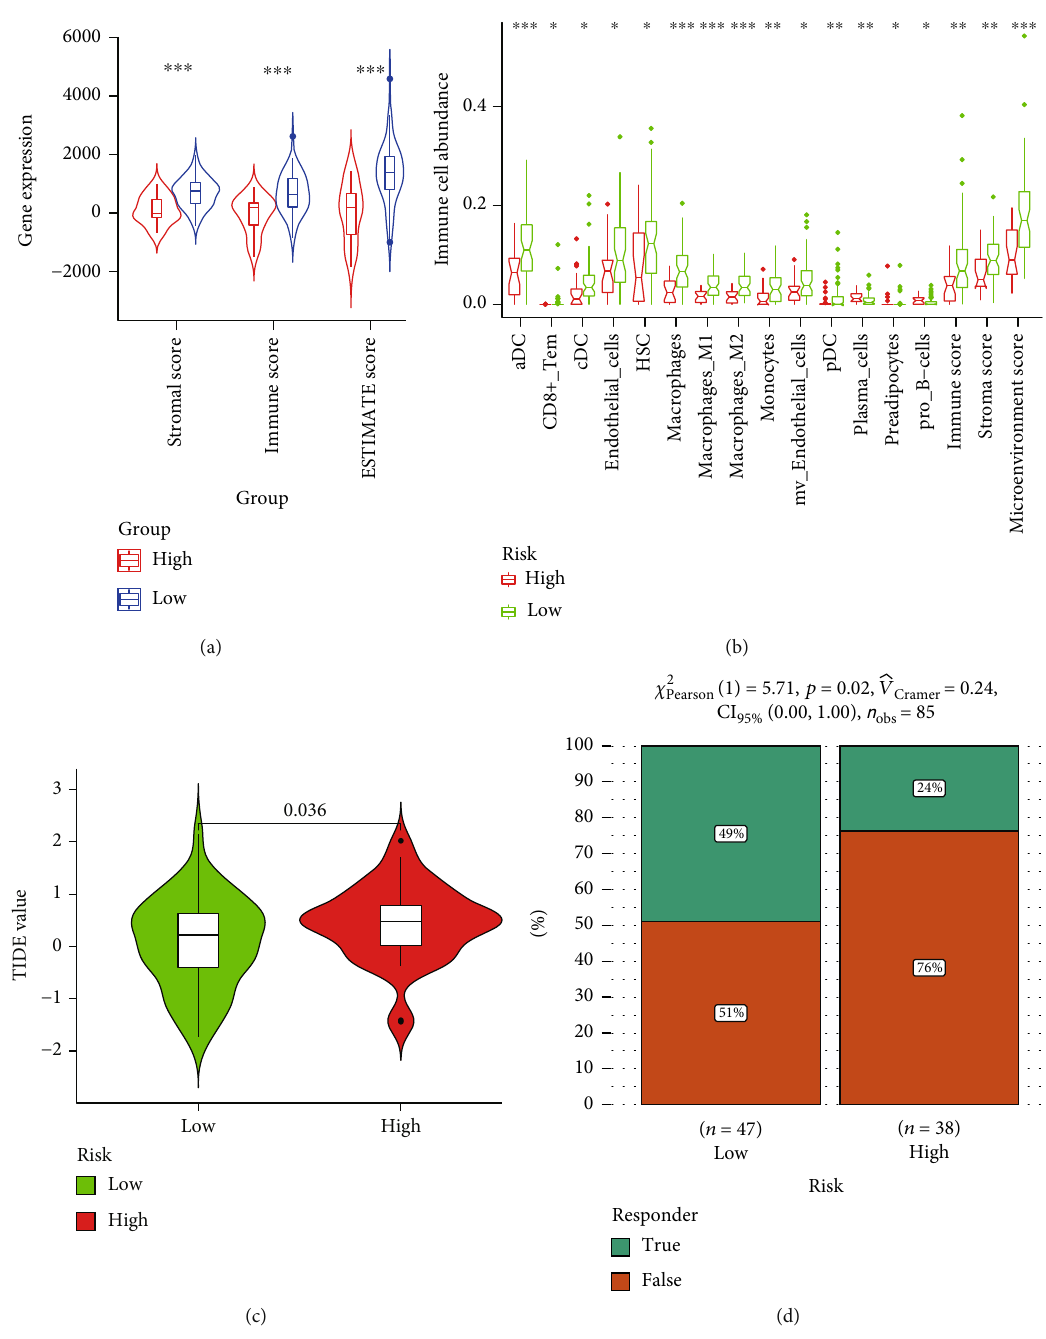
Figure 6: Correlation of risk scores with immune pro fi les of OS. (a) Comparison of the stromal score, immune score, and ESTIMATE score between high-risk and low-risk groups. (b) Comparison of immune cell in fi ltration between high-risk and low-risk groups. (c) Comparison of TIDE value between high-risk and low-risk groups. (d) Comparison of the response to immunotherapy in patients with OS in high-risk and low-risk